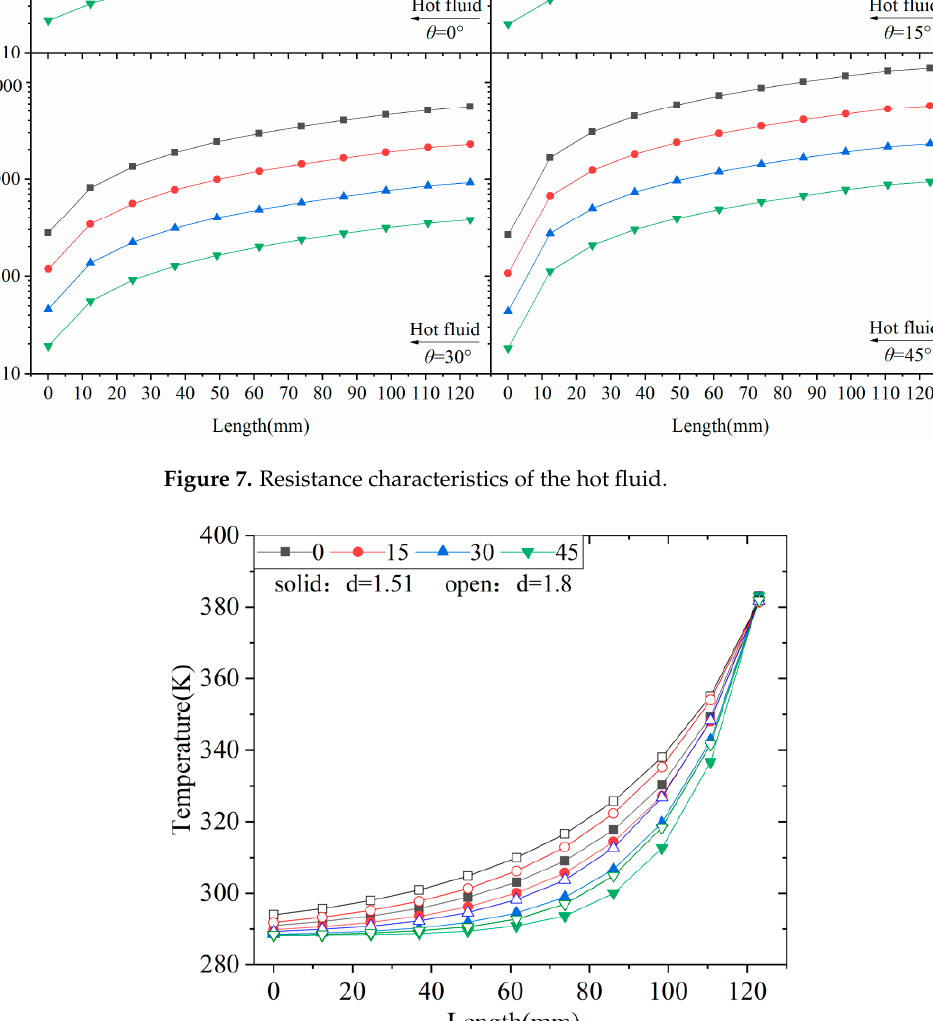
Figure 7. Resistance characteristics of the hot fluid.